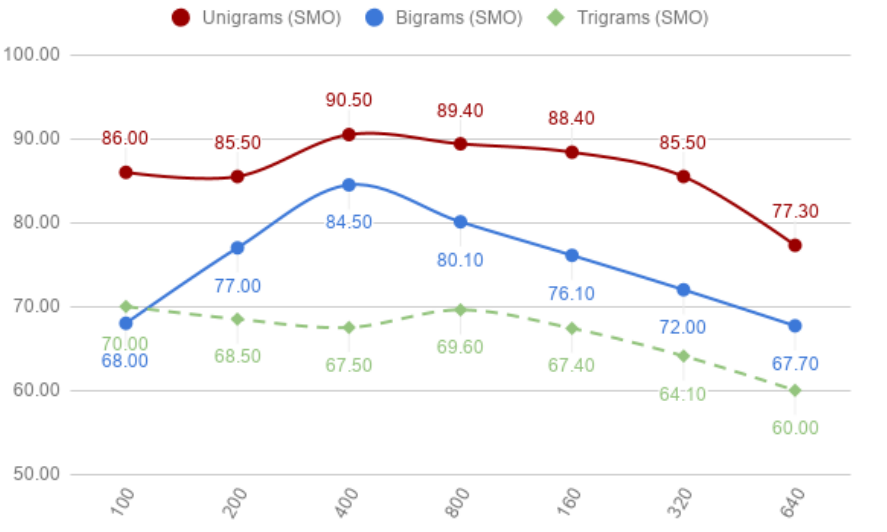
Figure 5. Word-grams: unigrams, bigrams and trigrams of sequential minimal optimization (SMO) classifier per